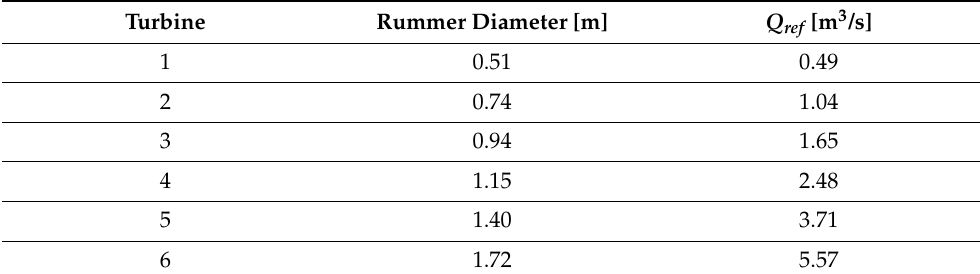
Table 5. Runner diameter and reference discharge Q ref for all considered turbines.